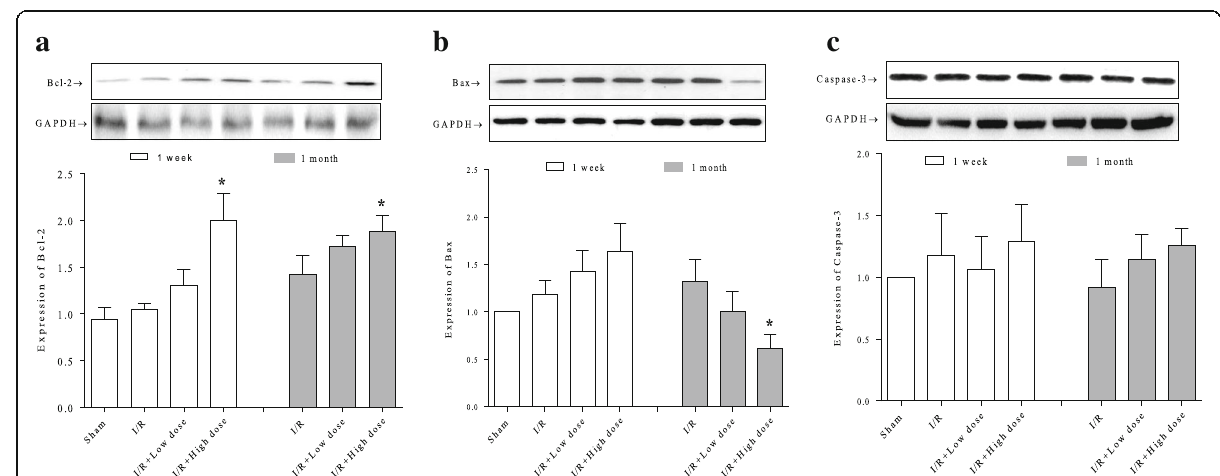
Fig. 2 Effects of MYQ on the expression of Bcl-2, Bax, Caspase-3. a Expression of the anti-apoptotic protein Bcl-2, upper is the representative blots of Bcl-2 and GAPDH; lower is the densitometric analysis of Bcl-2 expression normalized to GAPDH ( n = 8). b Expression of the pro-apoptotic protein Bax, upper is the representative blots of Bax and GAPDH; lower is the densitometric analysis of Bax expression normalized to GAPDH ( n = 8). c Expression of the caspase-3, upper is the representative blots of caspase-3 and GAPDH; lower is the densitometric analysis of caspase-3 expression normalized to GAPDH ( n = 8). Sham: Sham group; I/R: ischemic/reperfusion group. I/R + Low dose: Low dose (1 ml, P.O. tid for one-week or 1 month) MYQ treatment group. I/R + High dose: High dose (4 ml, P.O. tid for one-week or 1 month) MYQ treatment group. All data were expression as mean ± S.E.M. * P < 0.05 compared with I/R